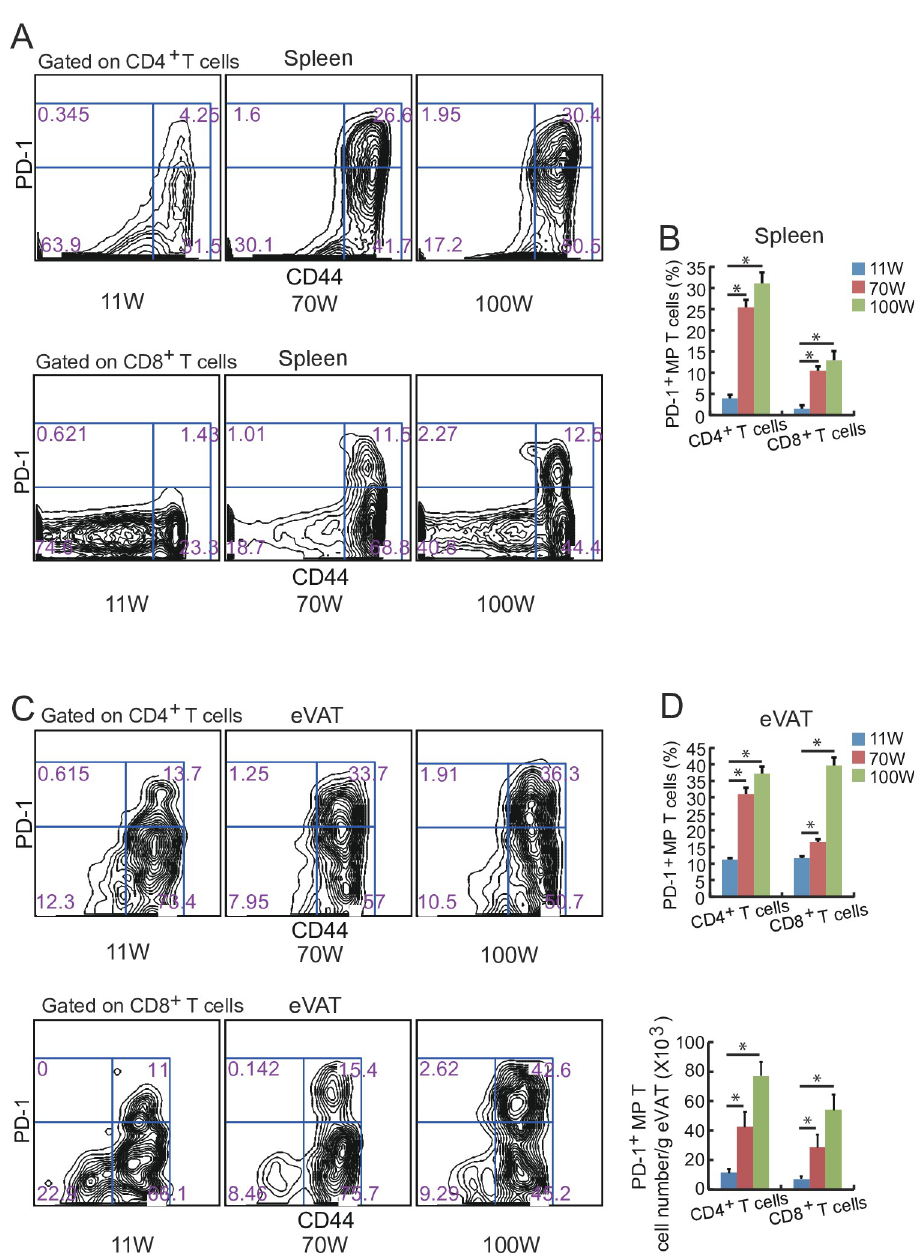
Fig 3. The increase in the PD-1 + T-cell subpopulation is associated with advanced age. ( A, B ) Flow cytometric analysis of PD-1 + CD44 + CD4 + T cells and PD-1 + CD44 + CD8 + T cells in spleen cells of WT mice of different ages fed with a ND ( n = 5–6 mice in each group). ( C, D ) Flow cytometric analysis of PD-1 + CD44 + CD4 + T cells and PD-1 + CD44 + CD8 + T cells from the stromal vascular fraction (SVF) from the eVAT of WT mice of different age fed an ND. ( n = 5–6 mice in each group). � P < 0.05; NS: not significant. Data are represented as the mean ±